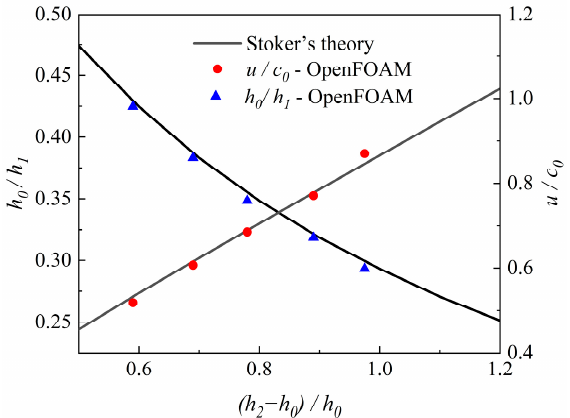
Figure 6. Comparison between the numerical model and Stoker’s theoretical solution.